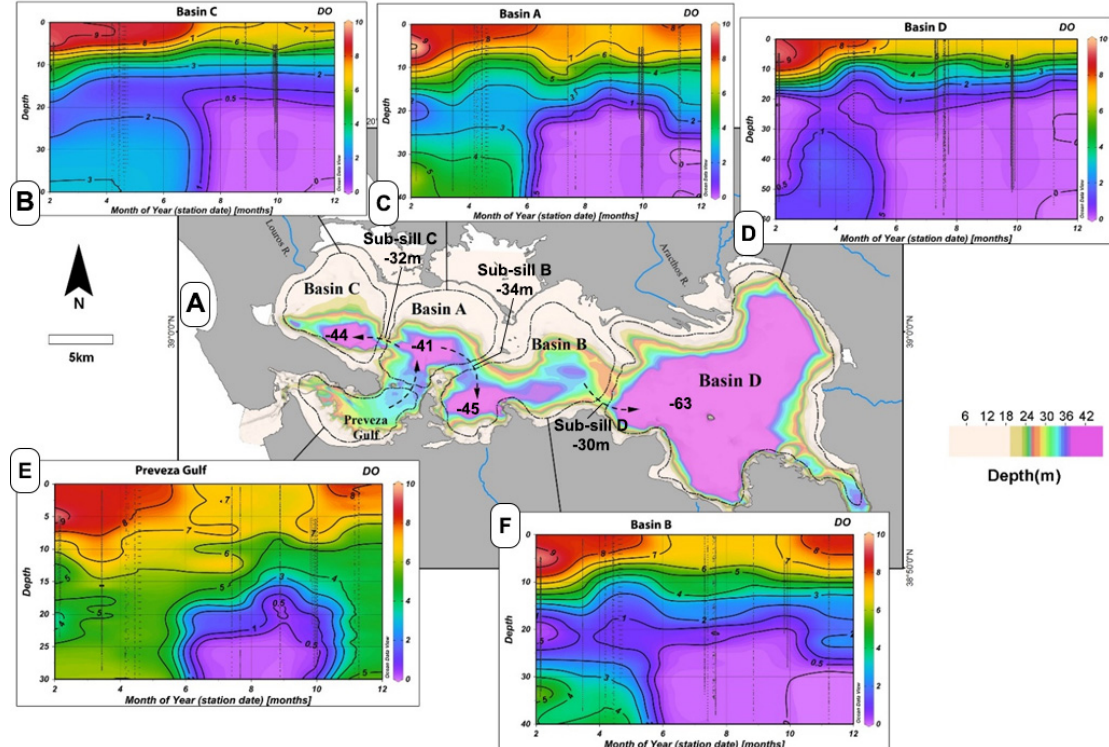
Figure 9. Bathymetry of Amvrakikos Gulf and Basins A, B, C, D locations ( A ), and DO distribution throughout the year in Basin C ( B ), Basin A ( C ), Basin D ( D ), Preveza Gulf ( E ), and Basin B ( F